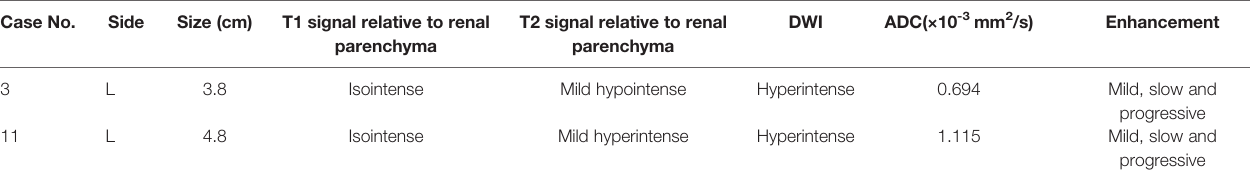
TABLE 5 | MR characteristics of primary tumor. Case